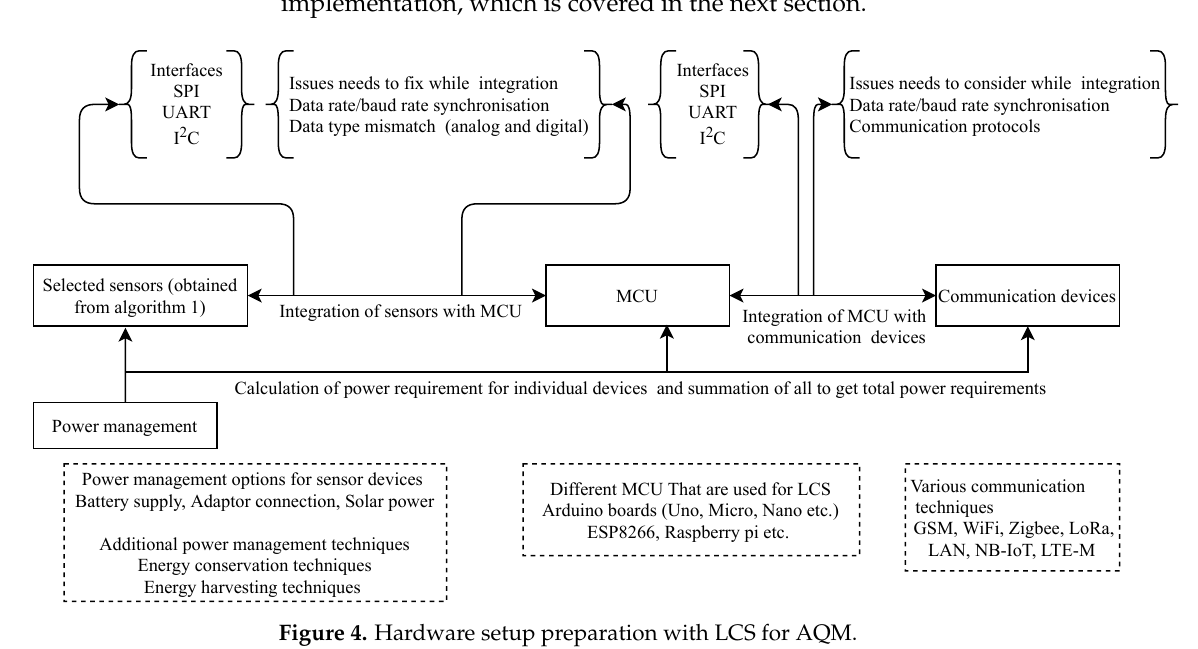
Figure 4. Hardware setup preparation with LCS for